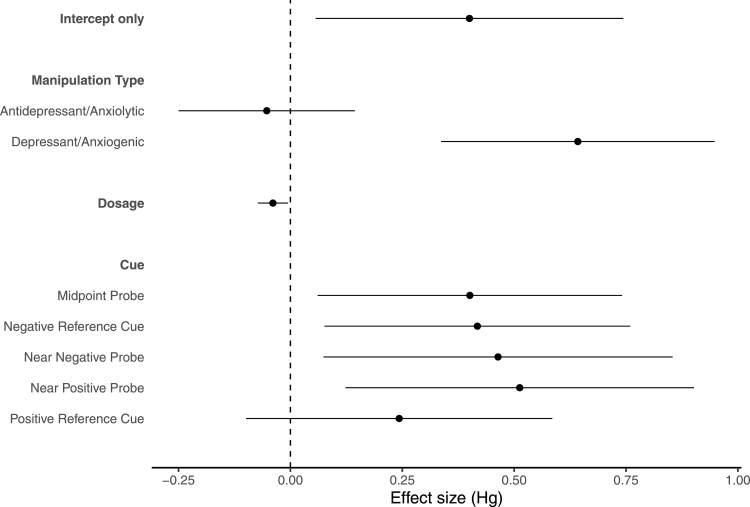
Forest plot with a meta-analytic mean (intercept-only model) and significant moderators from univariate meta-regression models following the exclusion of adrenergic system targeting drugs. Each point represents the mean effect size for each moderator and error bars represent the 95% confidence interval.